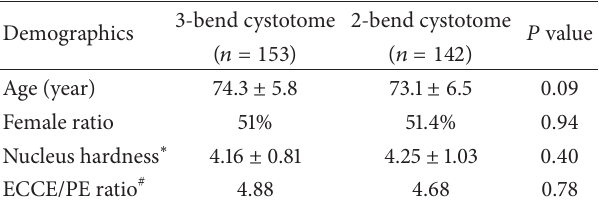
Table 1: Characteristics of eyes in the 3-bend and 2-bend groups before